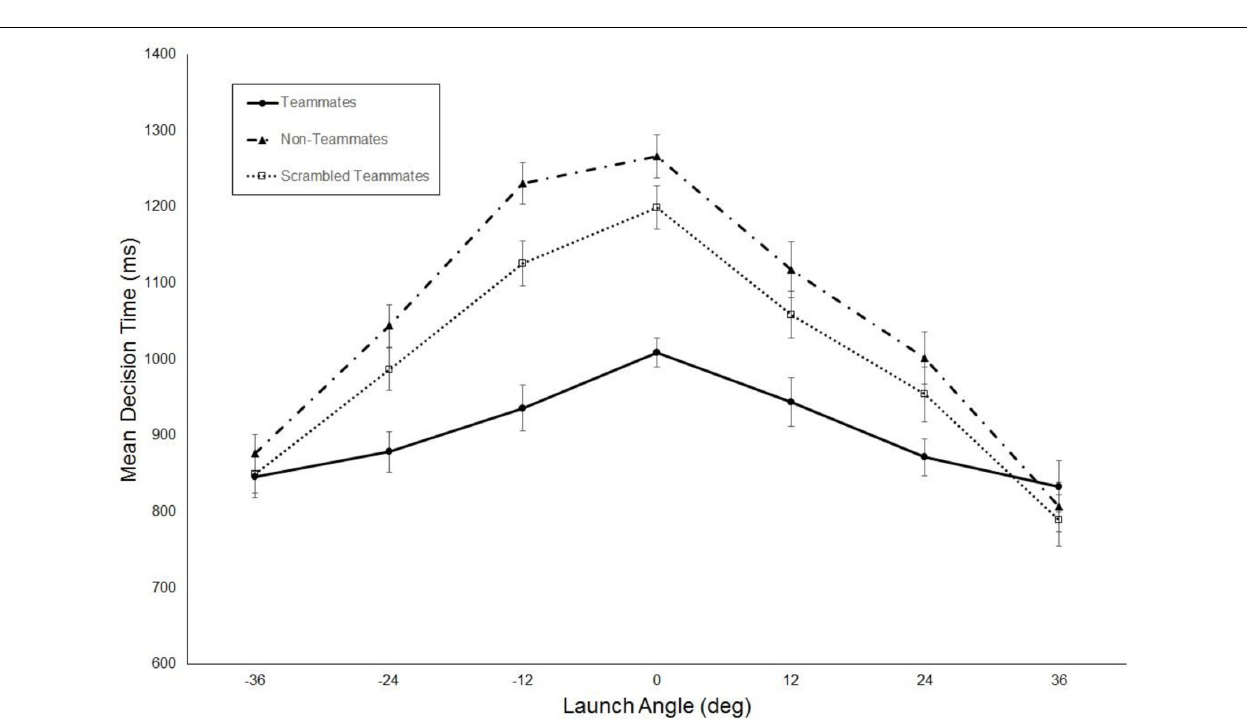
FIGURE 4 | Mean decision times plotted as a function of ball launch angle. Error bars are standard